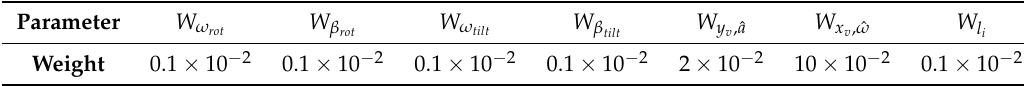
Table 2. Constant tuning